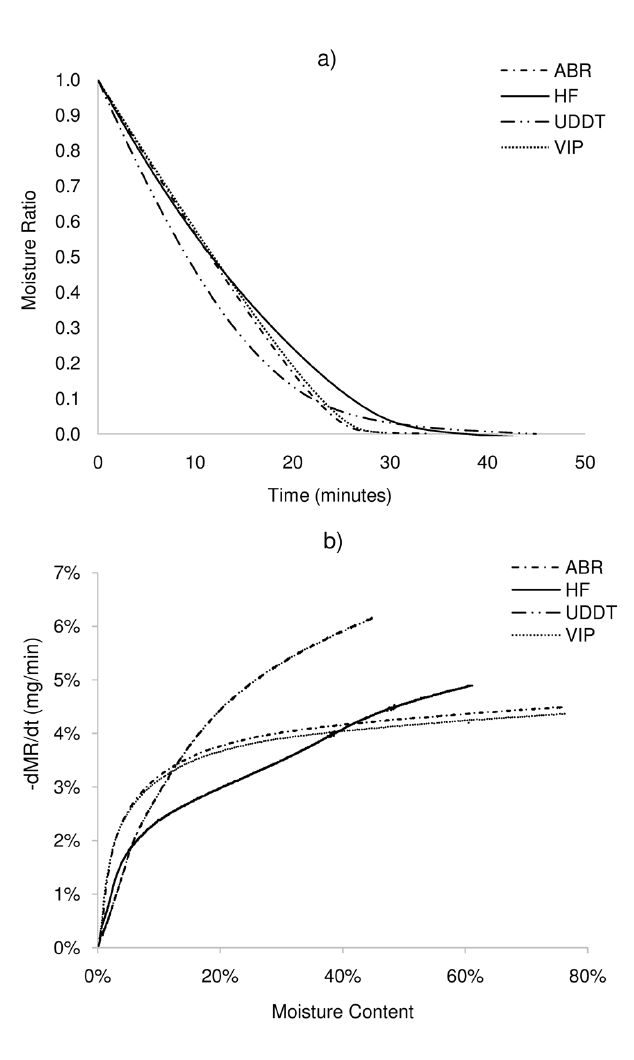
Figure 1. The isothermal drying curves of ABR, HF, UDDT and VIP at 55°C. a ) moisture ratio vs time, b ) moisture ratio derivative (drying rate) vs moisture content. ABR, anaerobic baffled reactor; HF, human faeces; UDDT, urine-diverting dry toilet; VIP, ventilated improved